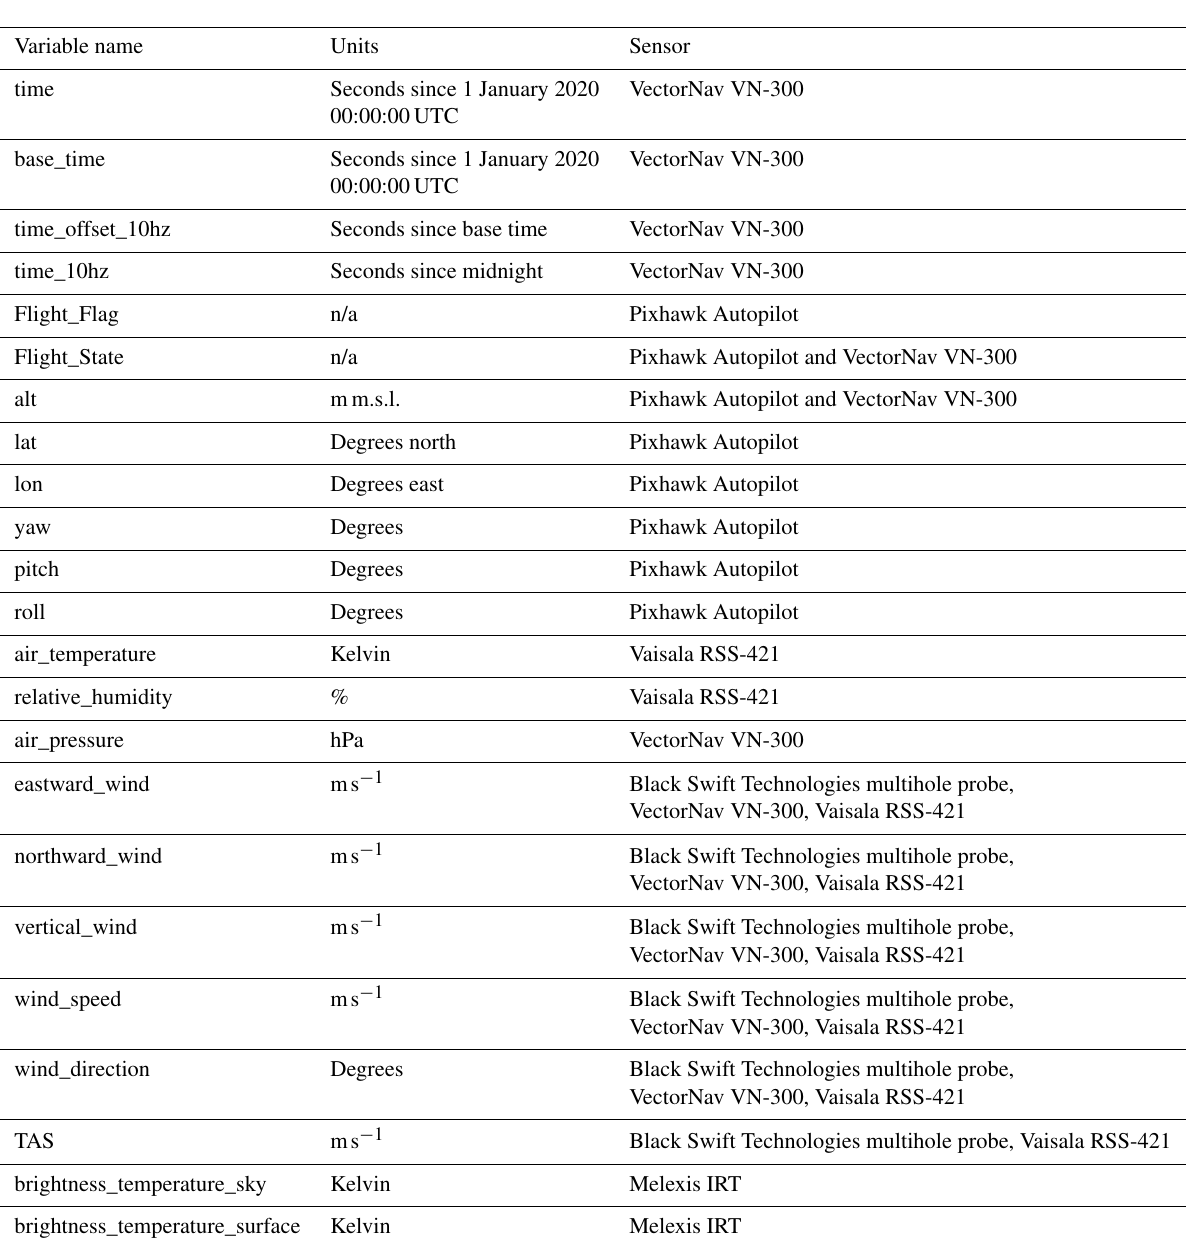
Table A1. A list of variables included in the B1 data files, the units for each variable, and the sensors used to derive that variable. Note that the data quality flags for each variable are not included in this list but are included in the NetCDF